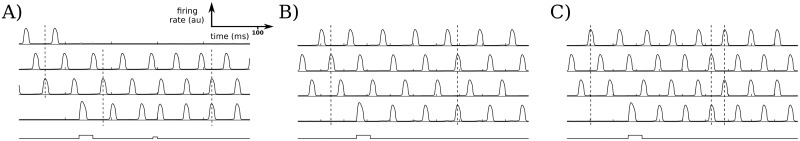
MP dynamics.(A) Stimulating an inactive population when the network is already at capacity (3 OP populations here) may cause one of the active populations to become quiescent, even without a strong stimulus. A subsequent stimulus produces similar behavior as in Fig 4B, so that stimulating an active population may allow it to change its relationship from pairwise OP with both other active populations to oscillate S with one of the two other active populations, and OP with the second. (B–C) Stimulating a quiescent population can cause various dynamic bindings and MP dynamics. For example, changing only the timing of the stimulus can alter the resulting patterns of synchronization. In (B), the stimulated population synchronizes with one of the three OP populations. (C) Adjusting the onset time of the stimulus may result in additional interactions, so that the network transitions from 3 OP populations to 2 OP pairs, where both populations in each pair oscillate S.